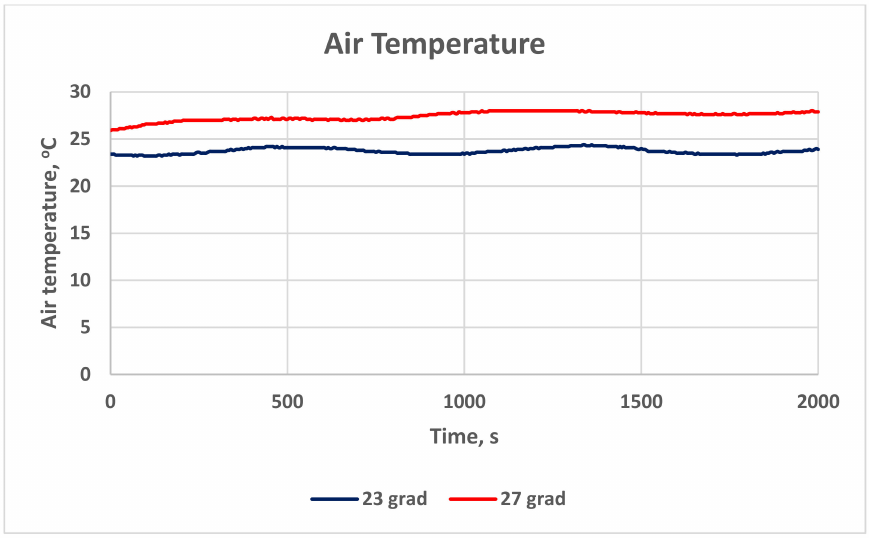
Figure 14. Air Temperature in the classroom during Stage 1 (27 ◦ C) and Stage 2 (23 ◦ C). The relative humidity measurements are shown in Figure 15. The relative humidity in Stage 1 is 43.8 ± 1.3%, and in Stage 2, it is 52.9 ± 1.2%. The air pressure in the classroom remains constant during the measurements: 946.6